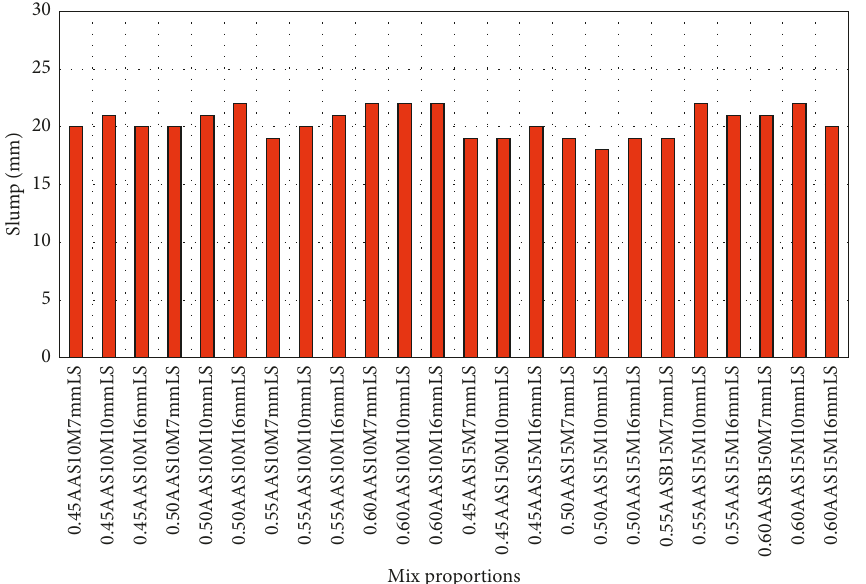
Figure 5: Slump of the AAHFAC